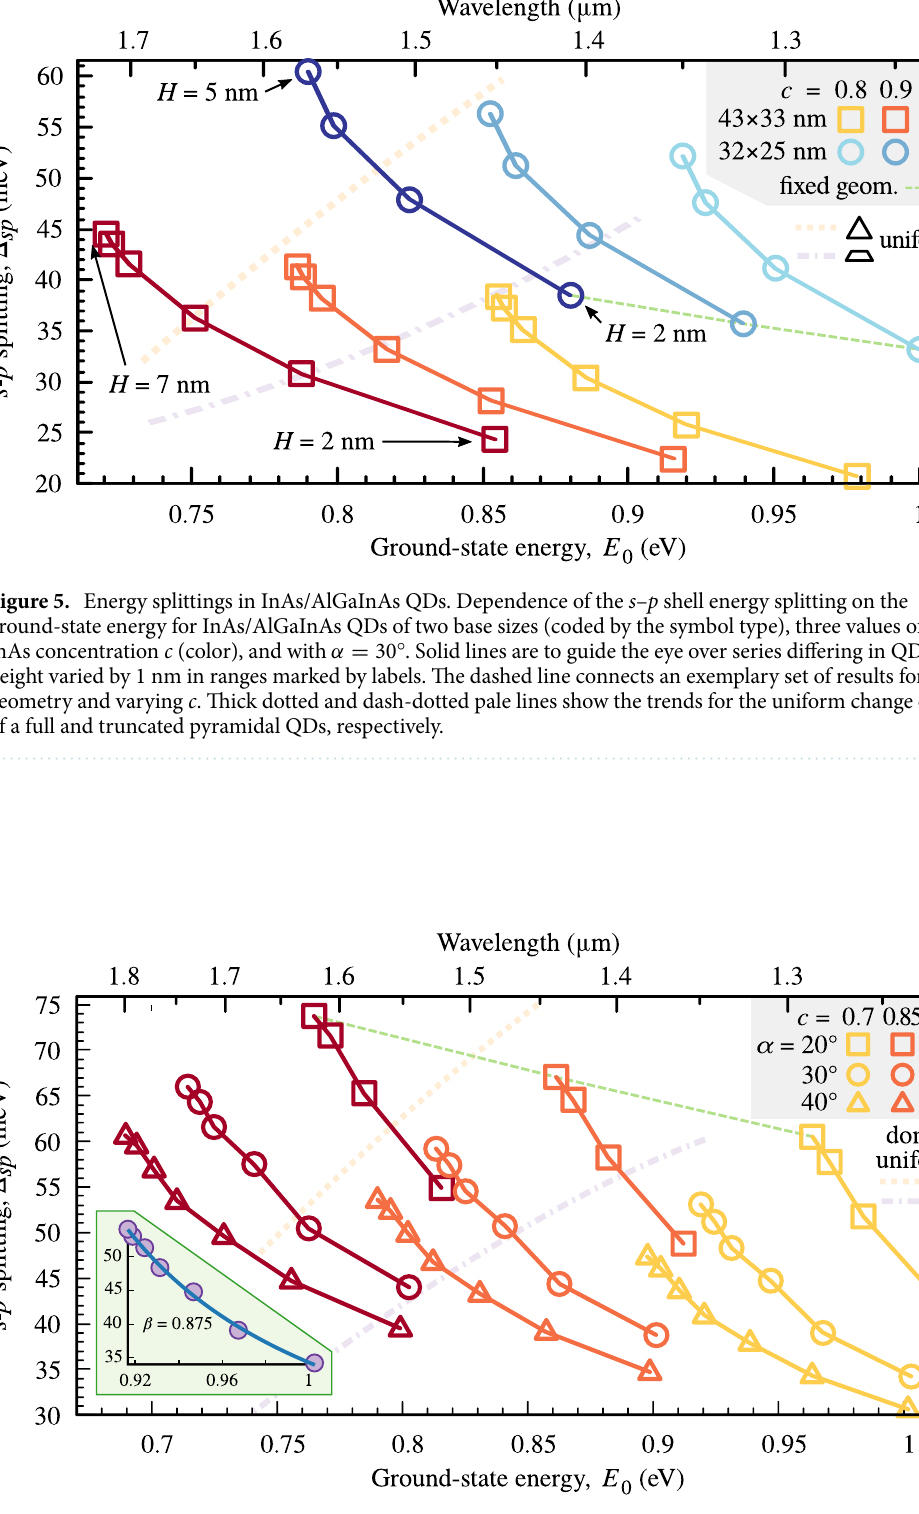
Figure 6. Energy splittings in InAs/InP QDs. Dependence of the s – p shell energy splitting on the ground-state energy for InAs/InP QDs with three sidewall inclination angles (coded by the symbol type), three values of InAs W 30 nm. Solid lines are to guide the eye over series differing in QD concentration c (color), and with L = = height varied by 0.6 nm starting from 1.8 nm. The dashed line connects an exemplary set of results for fixed geometry and varying c . Thick dotted and dash-dotted pale lines show the trends for the uniform change of size of typical dome-shaped QDs with radius to height ratios of 3 and 6, respectively. The inset shows an exemplary fit with Eq.